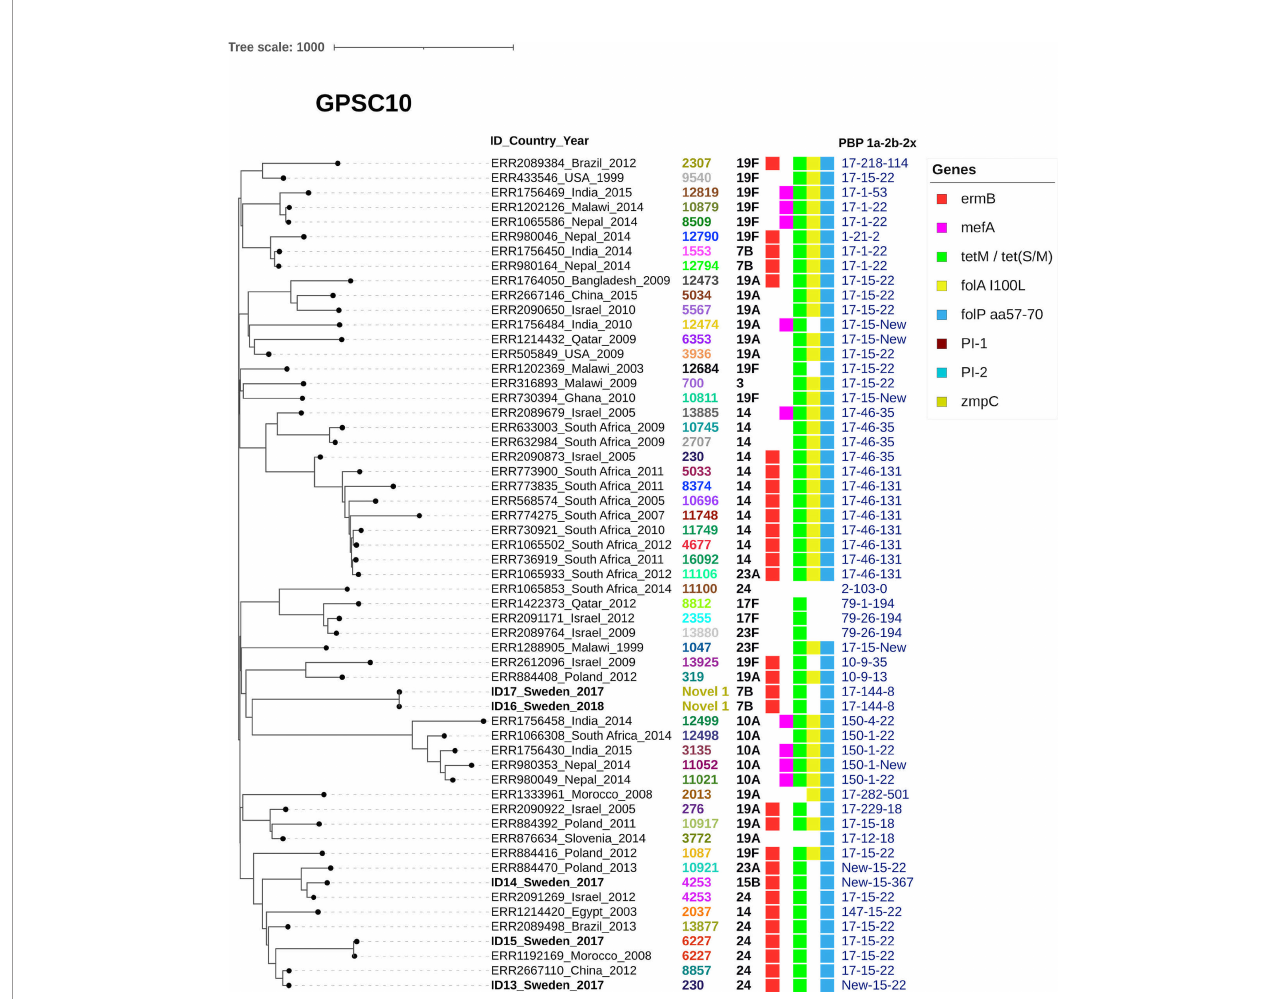
FIGURE 3 | GPSC10 lack both pilus islets and ZmpC. GPSC10 tree including 57 isolates showing ID number, Country and Year followed by serotype, MLST, gene presence and PBP-pro fi le (1a-2b-2x). As a reference isolate ID 13 was used. All the Swedish isolates and all the included 100% harbored the zink metalloproteinase C gene ( zmpC ). Macrolide resistance mechanism ermB was mostly present in different sub-clades with serogroup 24, serotype 14 or 7B isolates. Regarding the PBP pro fi le PBP-1a allele 17 was common within the GPSC among our included isolates. None of the isolates carried either Pilus islet 1, Pilus islet 2 or